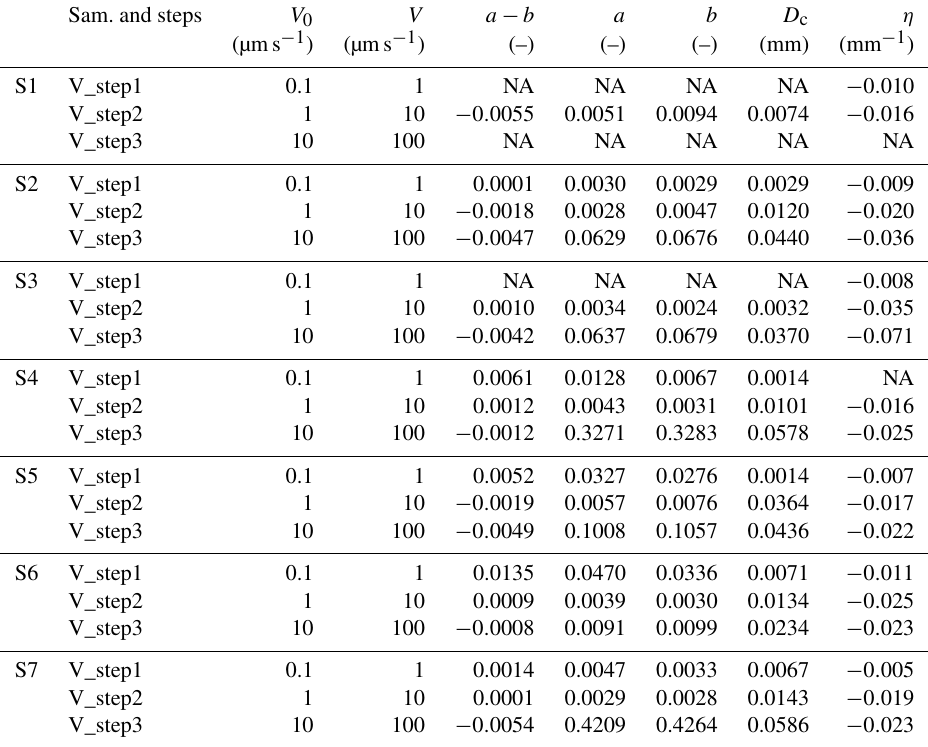
Table 2. Summary of RSF data for all velocity stepping experiments reported in this paper. Sam. and